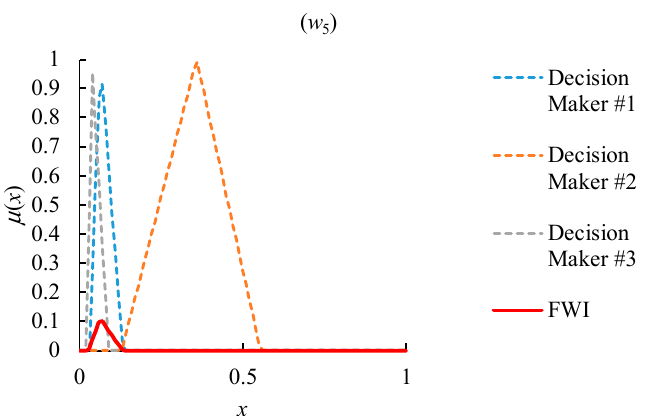
Figure 6. FWI results of the relative priorities based on the assigned authority levels.